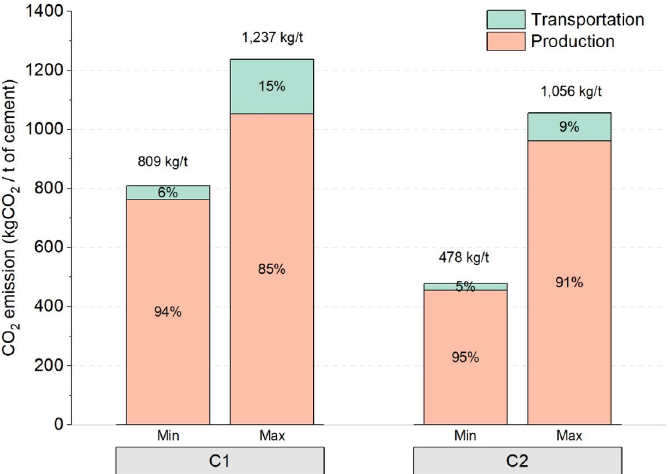
Figure 4. Minimum and maximum CO 2 emissions of cements considered in this